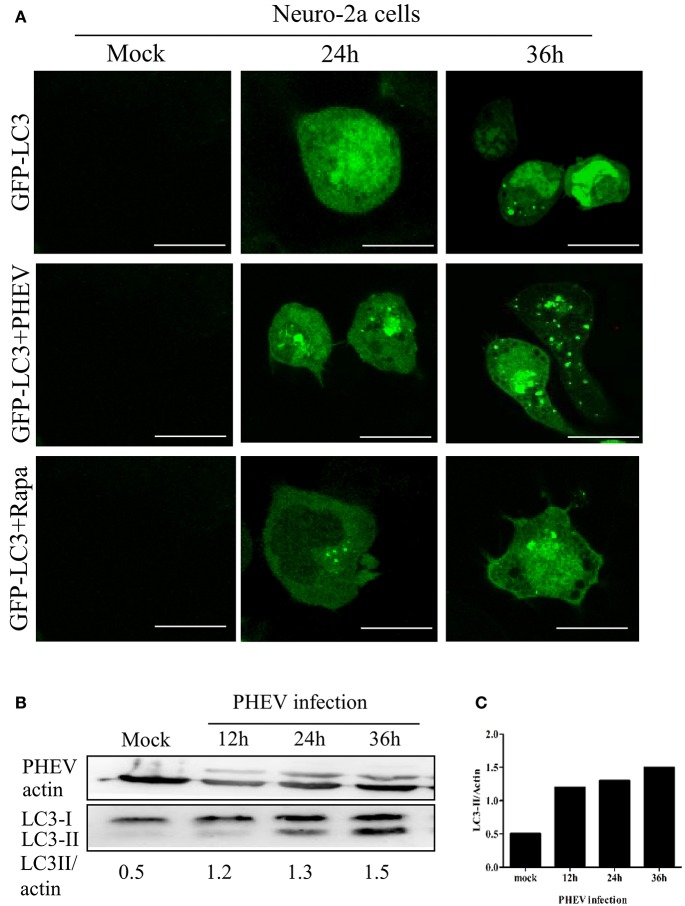
PHEV-induced autophagy was time-dependent. (A) Immunofluorescence microscopy was used to detect the GFP-LC3-autophagosomes in PHEV infected cells at different post-infection time points before transfection with GFP-LC3 into Neuro-2a cells. The cells were fixed at 0, 24, and 36 h post-infection, respectively, and then analyzed for GFP-LC3 positive autophagosome accumulation using a confocal microscope as described in Figure 2A. (B,C) Neuro-2a cells were infected with PHEV and mock-infected cells served as control. At 0, 12, 24, and 36 h post-infection, the cells were then lysed for western blotting analysis using an anti-LC3B and anti-β-actin antibodies. Scale bars: 10 μm.